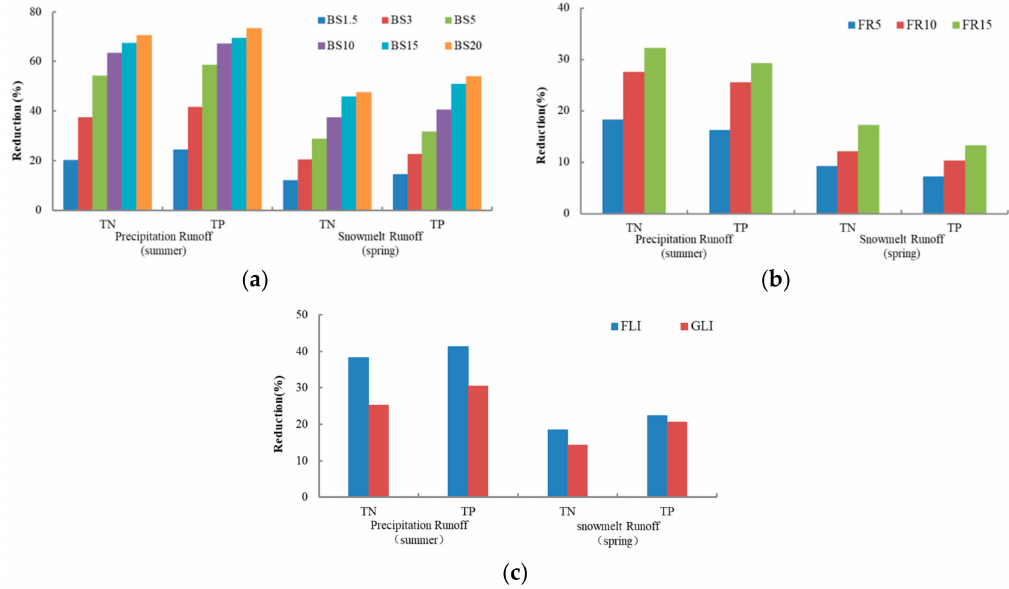
Figure 7. TN and TP loads reduction of the BMPs simulations. ( a ) Pollution loads reduction with di ff erent bu ff er strip widths. ( b ) Pollution loads reduction with di ff erent fertilizer reduction rate. ( c ) Pollution loads reduction with di ff erent land use management. Abbreviation: BS: Bu ff er strip (1.5 m, 3 m, 5 m, 10 m, 15 m, 20 m); FR: Fertilizer reduction (5%, 10%, 15%); FLI: Forest land increase; GLI: Grassland increase.